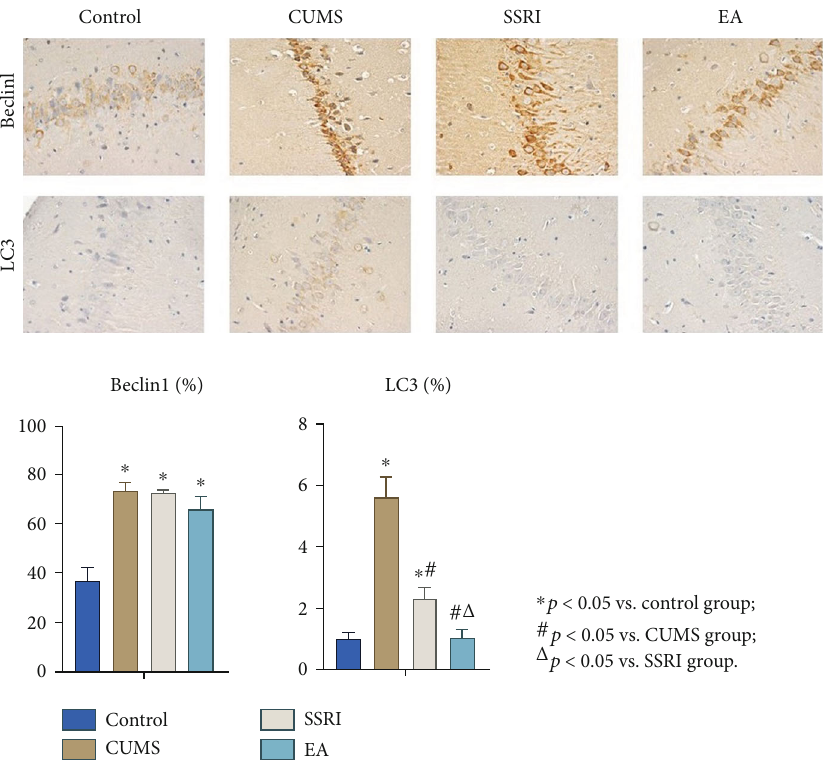
Figure 3: Expression of Beclin1 and LC3 in hippocampus CA1 of each group (IHC, 200x magni fi cation; mean ± SEM ; n = 6 ).